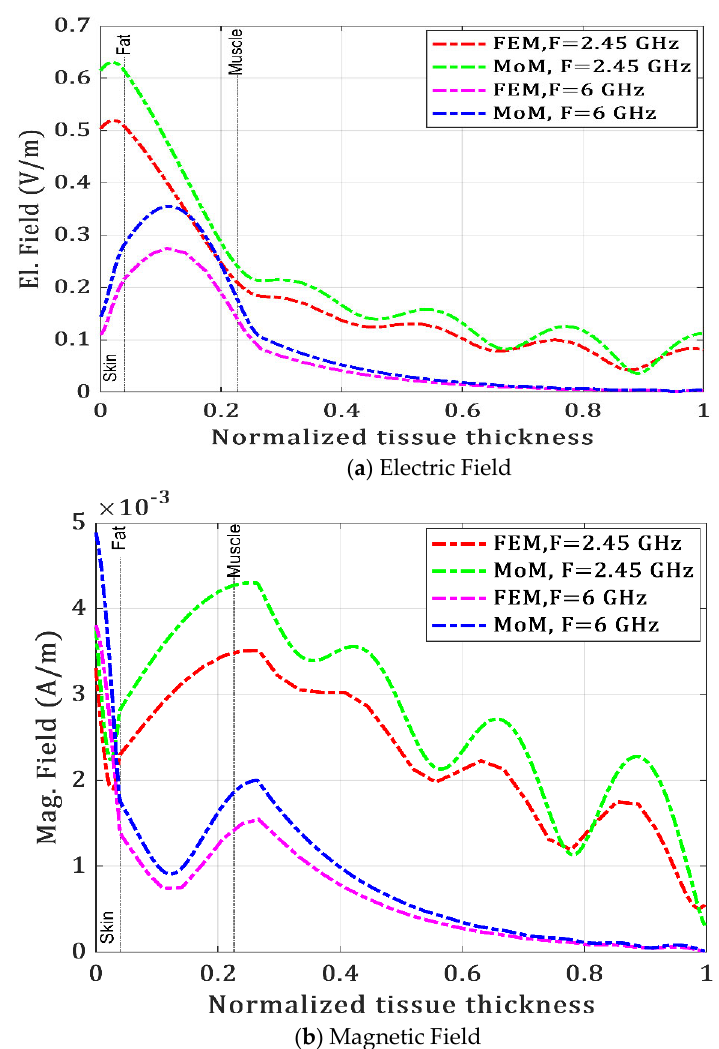
Figure 7. The EM field obtained by the MoM and FEM for OB2IB communication.